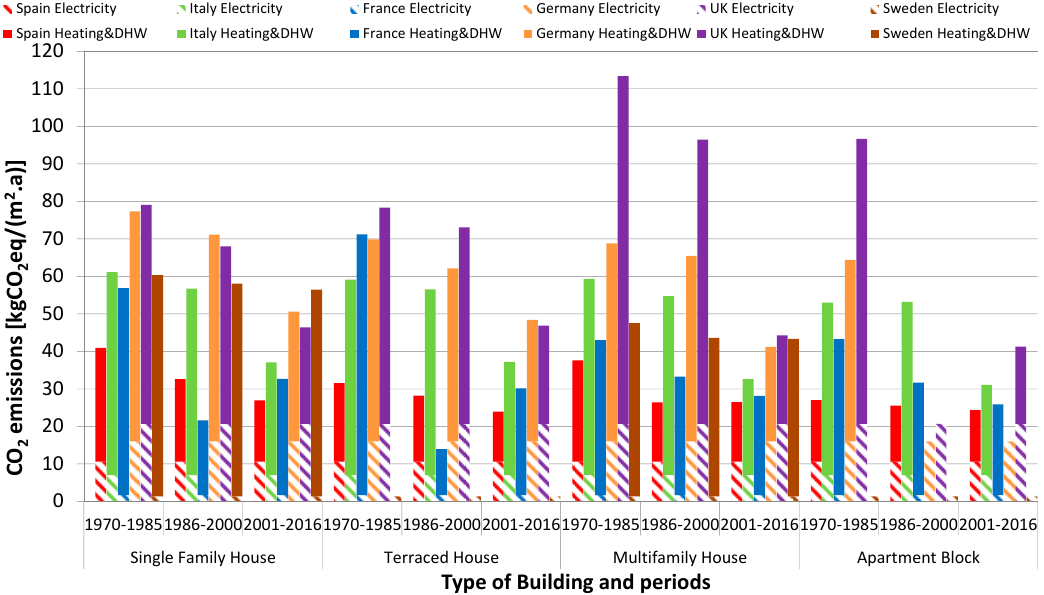
Figure 10. CO 2 emissions of electricity, heating and DHW consumption per square metre in temperate climates.